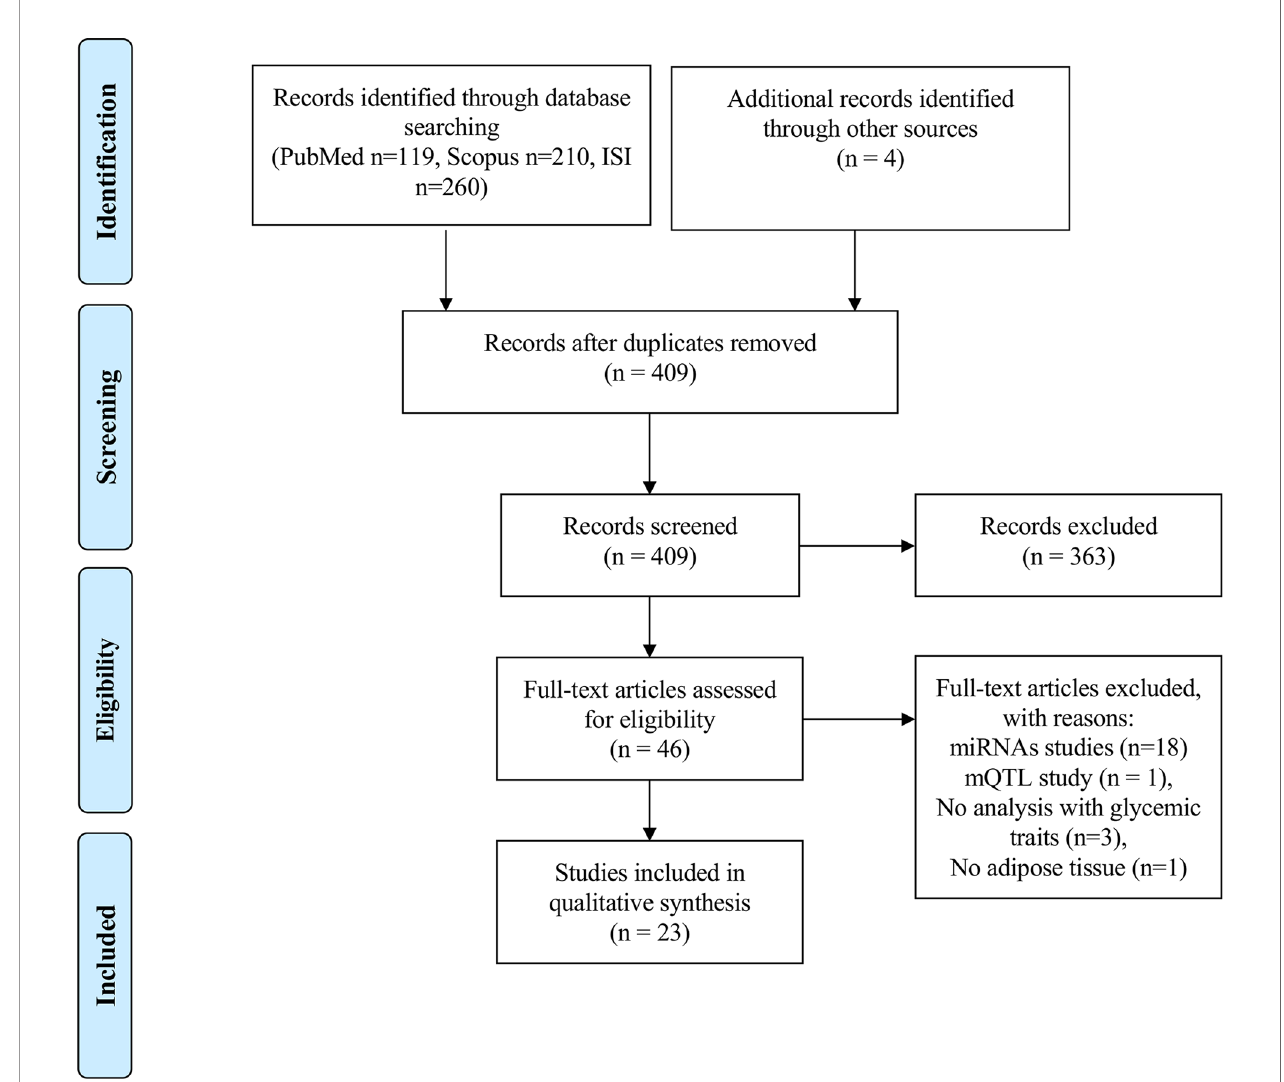
FIGURE 1 | PRISMA fl owchart on the literature selection